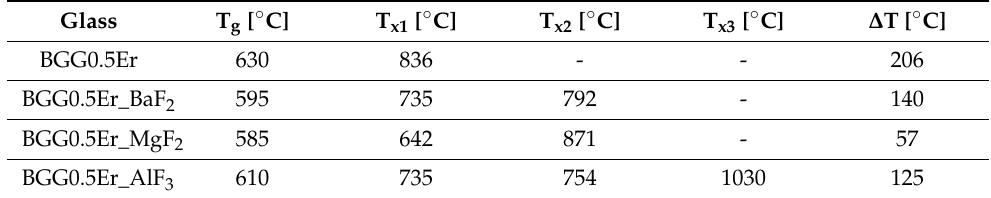
Table 1. Thermal properties of erbium-doped BGG glass modified by